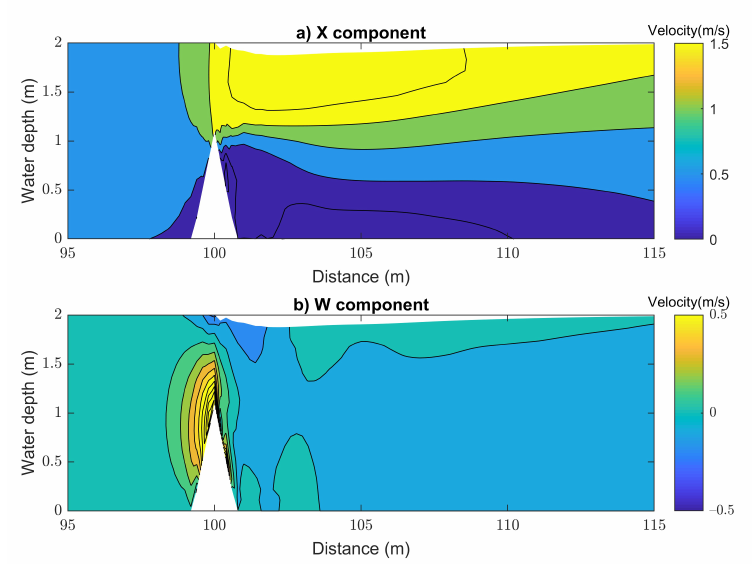
Figure 6. Along ( a ) and vertical velocities ( b ) with water depths in numerical experiment induced by the SND.